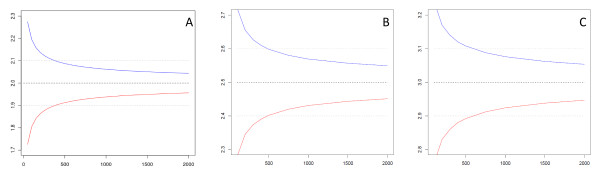
Function of sample size and 95%CI for (A) B(4*k, 05), (B) B(5*k, 05) and (C) B(6*k, 05).